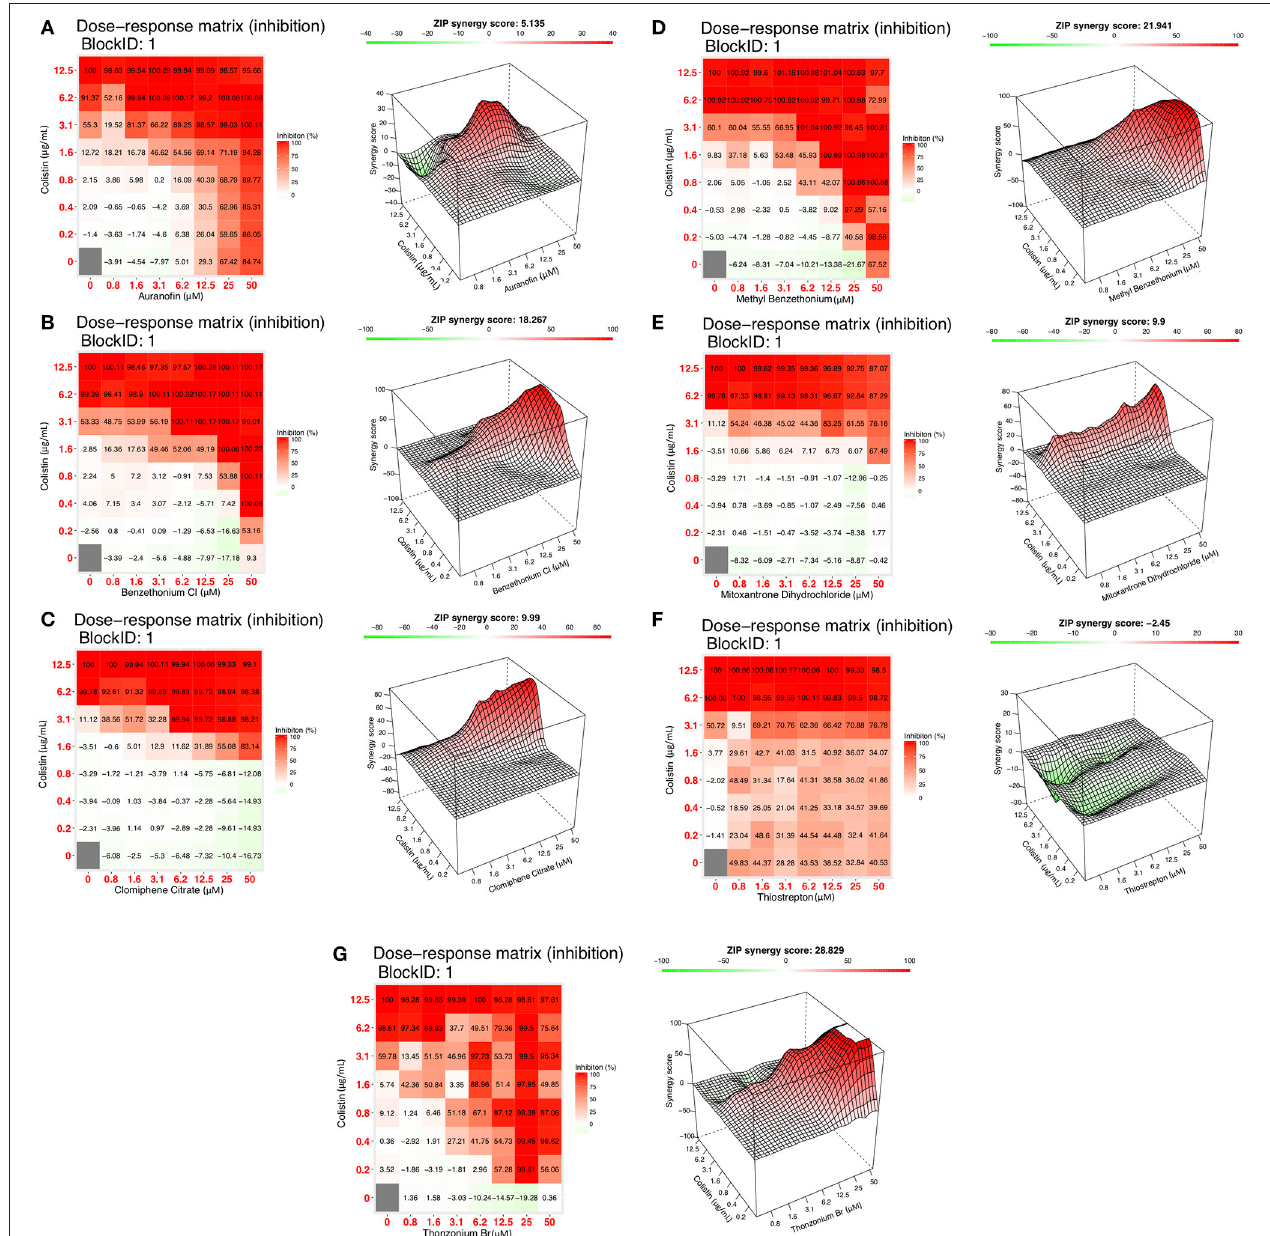
FIGURE 3 | Dose response matrix and ZIP synergy score surface plots of (A) Auranofin, (B) Benzethonium Cl, (C) Clomiphene Citrate. Dose response matrix and ZIP synergy score surface plots of (D) Methyl Benzethonium, (E) Mitoxantrone DHCl, (F) Thiostrepton. Dose response matrix and ZIP synergy score surface plots of (G) Thonzonium Br ( µ